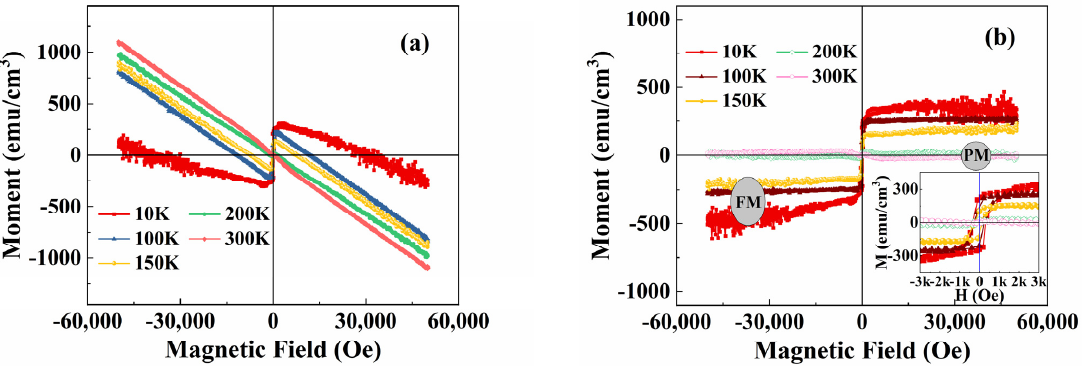
Figure 4. The M(H) loops of the PSMO film on SrTiO 3 at temperatures of 10, 100, 150, 200, 250, and 300 K. The applied magnetic field changes from − 50,000 to 50,000 Oe. ( a ) Represents the magnetic data without subtracting the diamagnetic background of the substrate; ( b ) shows the magnetic data by deducting the diamagnetic background of the substrate. The inset of ( b ) shows the partially enlarged view of the low magnetic field region.